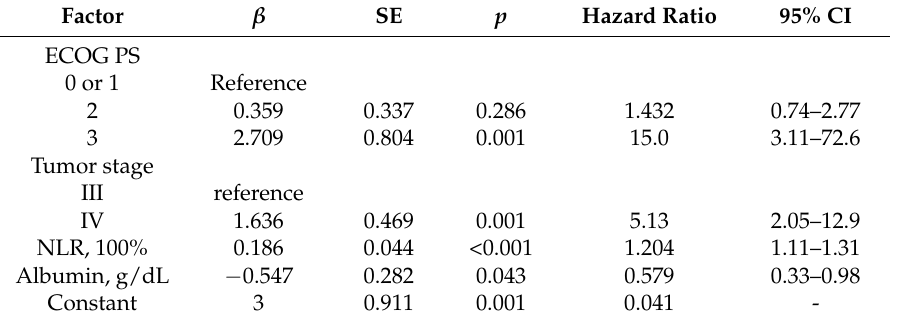
Table 3. β -coefficient of the prognostic factors defined by multivariate Cox